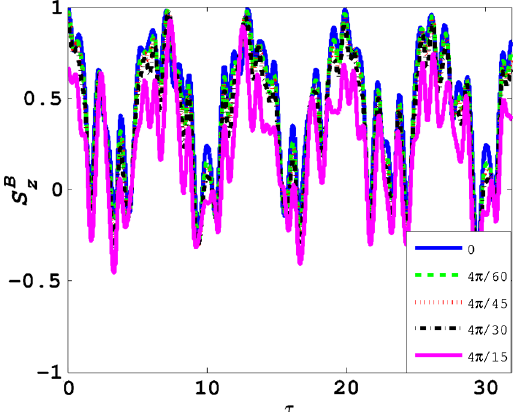
FIG. 6 (color online). Nutation of qubit B for five values of θ 0 B , the initial values of the polar angle θ B of qubit B . All parameter values are the same as in Fig. 2(d), J B z ¼ 0 . 3 J A z . Complexities of dynamics are due to the nonlinearity of both qubits and the crosstalk between them. See text for